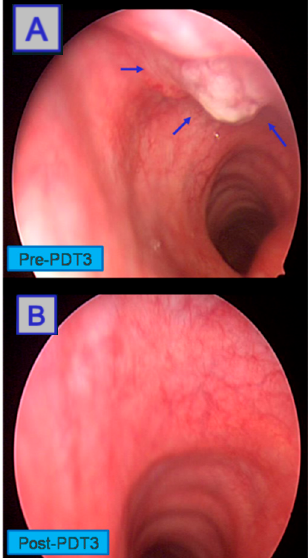
Figure 15. Third round of PDT carried out on remaining tumour regrowth ( A ). Intraoperative panendoscopy shows the complete response to treatment ( B ). Reprinted with permission from ref. [86]. Copyright 2010 Photodiagnosis Photodyn. Ther. Biel treated 115 patients with early laryngeal carcinomas (carcinoma in situ/T1/T2) with photofrin at a dose of 2 mg/kg and DLI of 48 h. A total of 105 patients showed a